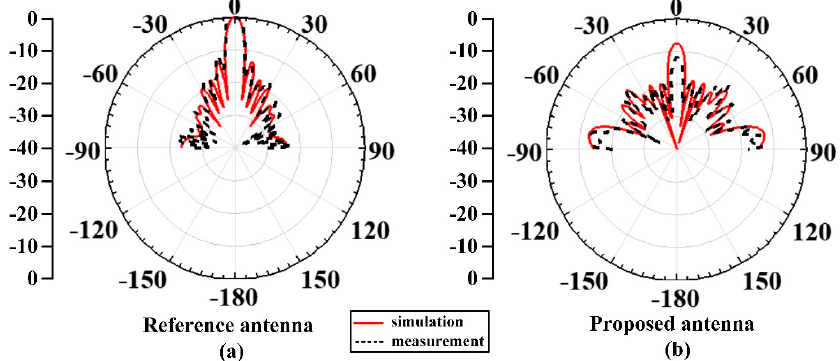
Figure 11. Normalized angular performance of monostatic RCS for x–z plane with HP incident wave at 10 GHz. ( a ) Reference antenna. ( b ) Proposed antenna.